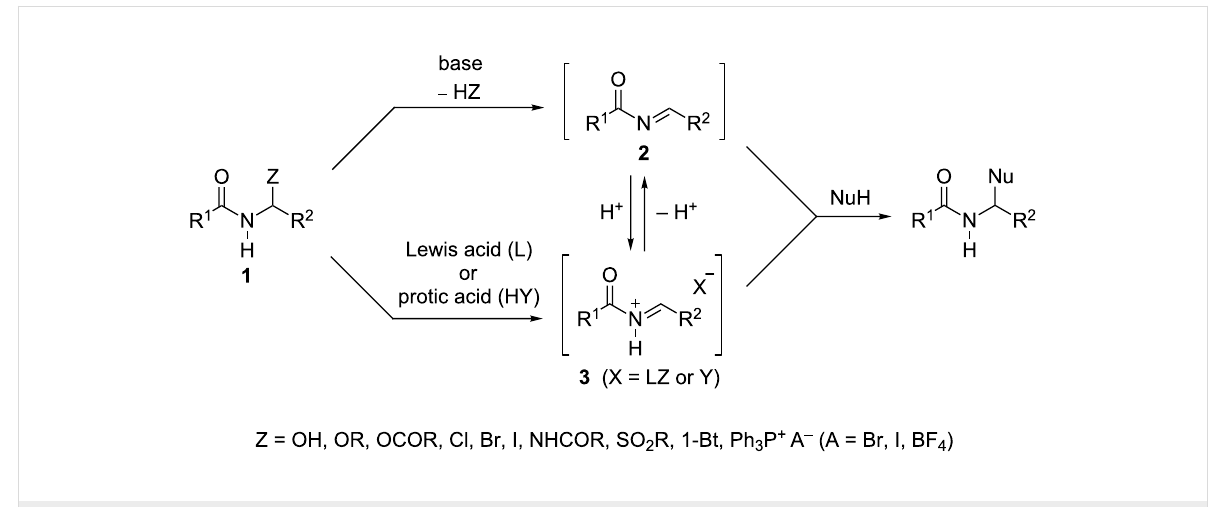
Scheme 1: α -Amidoalkylation reactions under basic or acidic